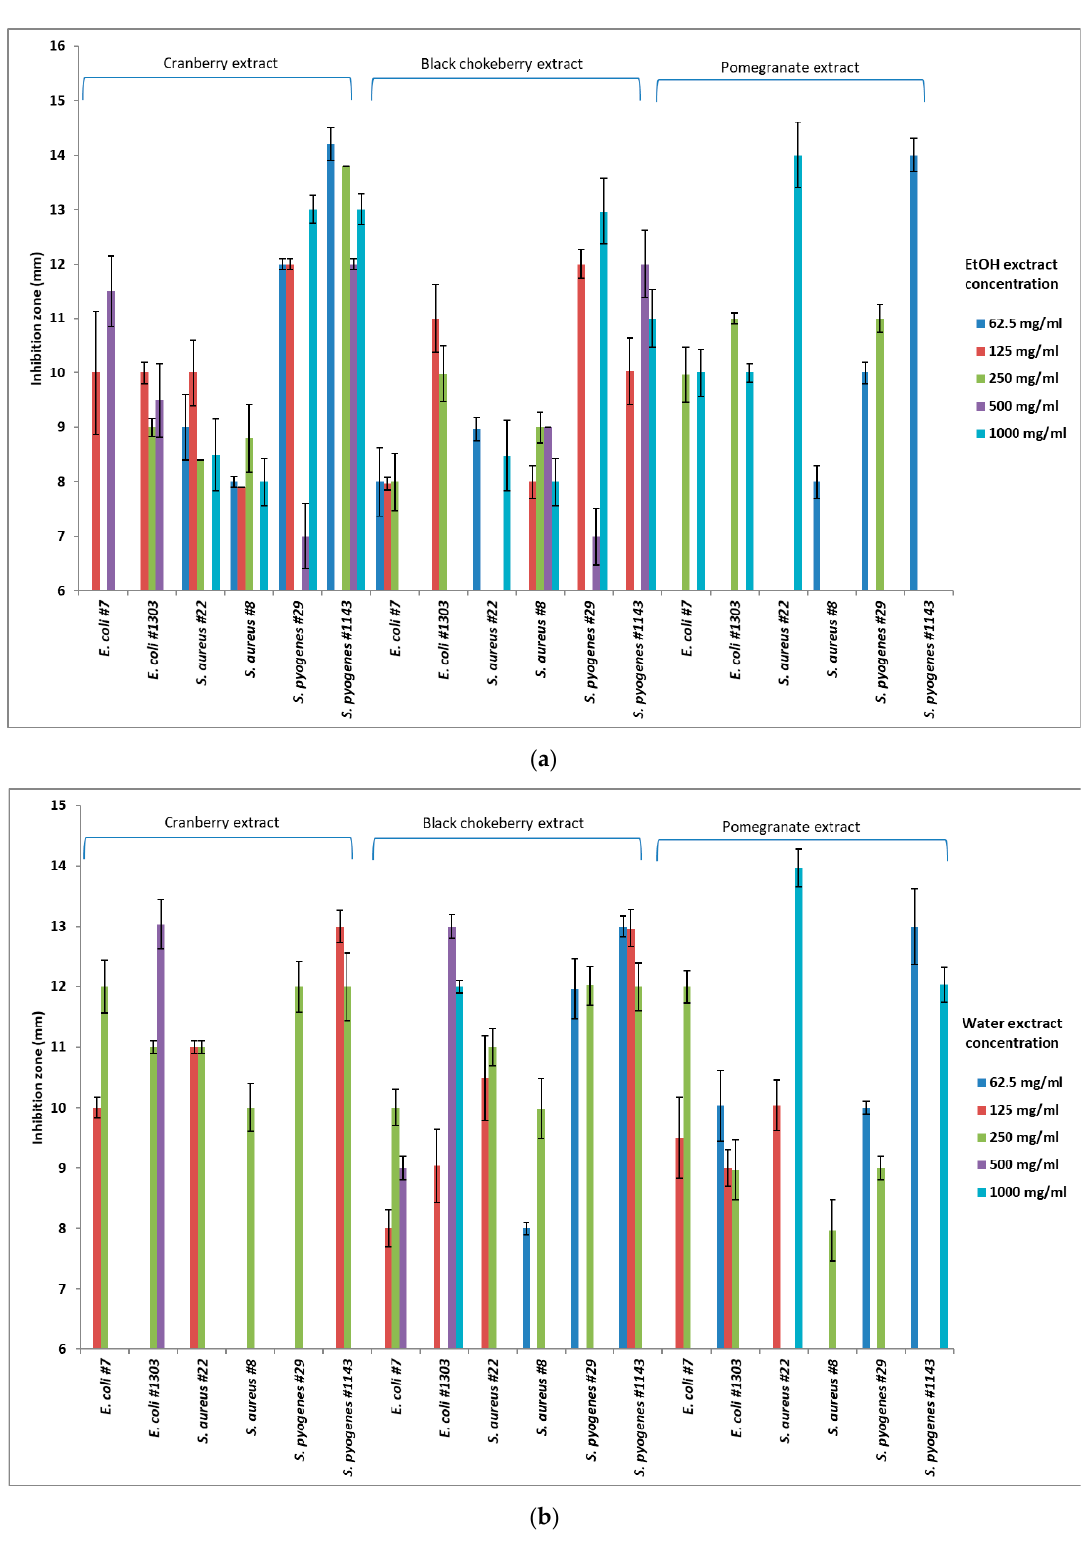
Figure 1. ( a ) Ethanolic extract concentration effectiveness (ZOI in mm ± SD) against different types of pathogens. ( b ) Aqueous extract concentration effectiveness (ZOI in mm ± SD) against different types of pathogens.